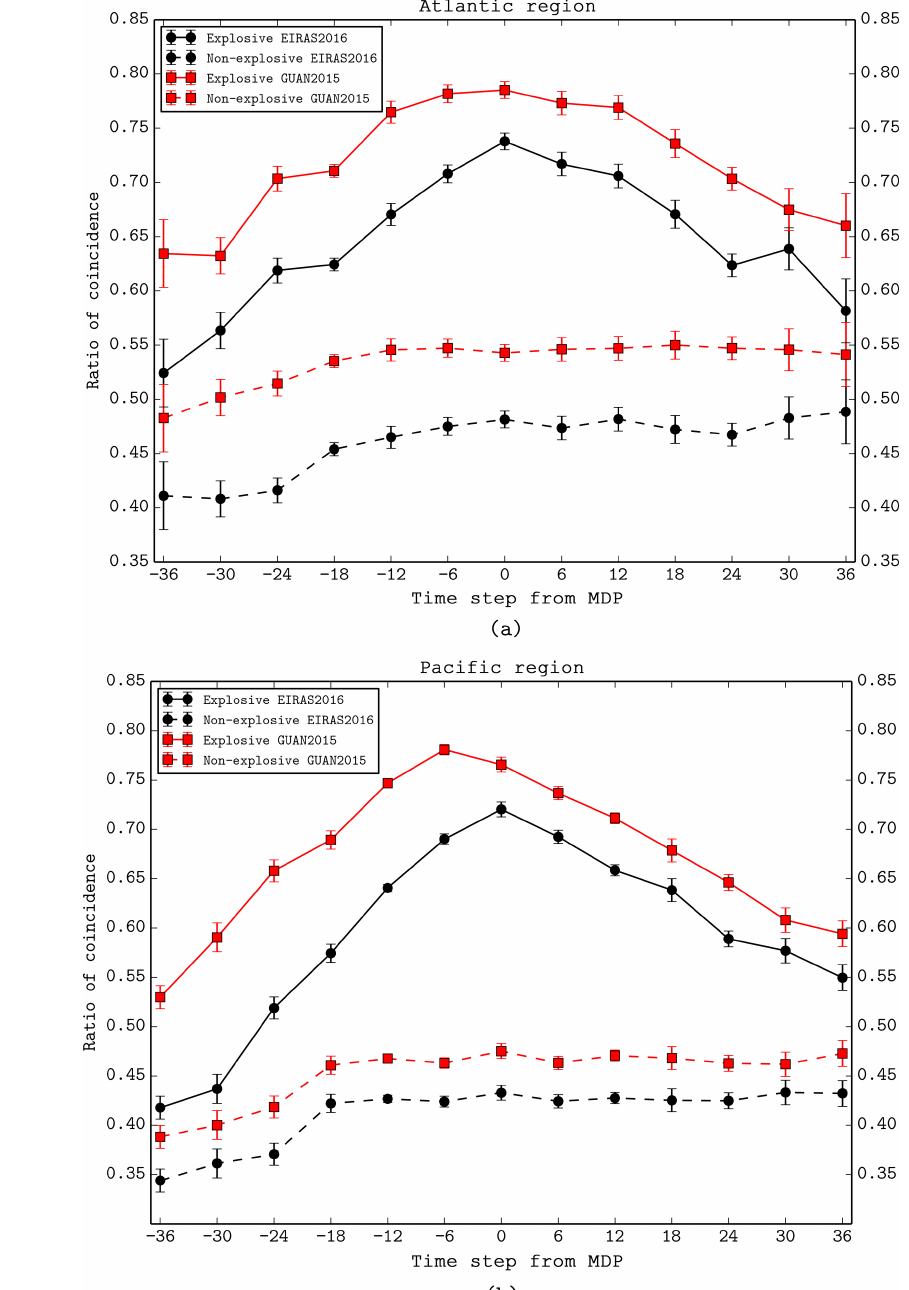
Figure 3. (a) Ratio of coincidence between the position of the cyclones for the North Atlantic Basin and the presence of an Atmospheric River in a 1500km radius. The maximum deepening point (MDP) is fixed as time reference and results are shown for ± 36h of the MDP. Red lines correspond to the GUAN2015 method and black lines to the EIRAS2016 method. Solid lines refer to explosive cyclogenesis (EC) and dotted lines refer to non-explosive events (NEC). (b) As (a) but for the North Pacific Basin. In addition the variance of each time step is also